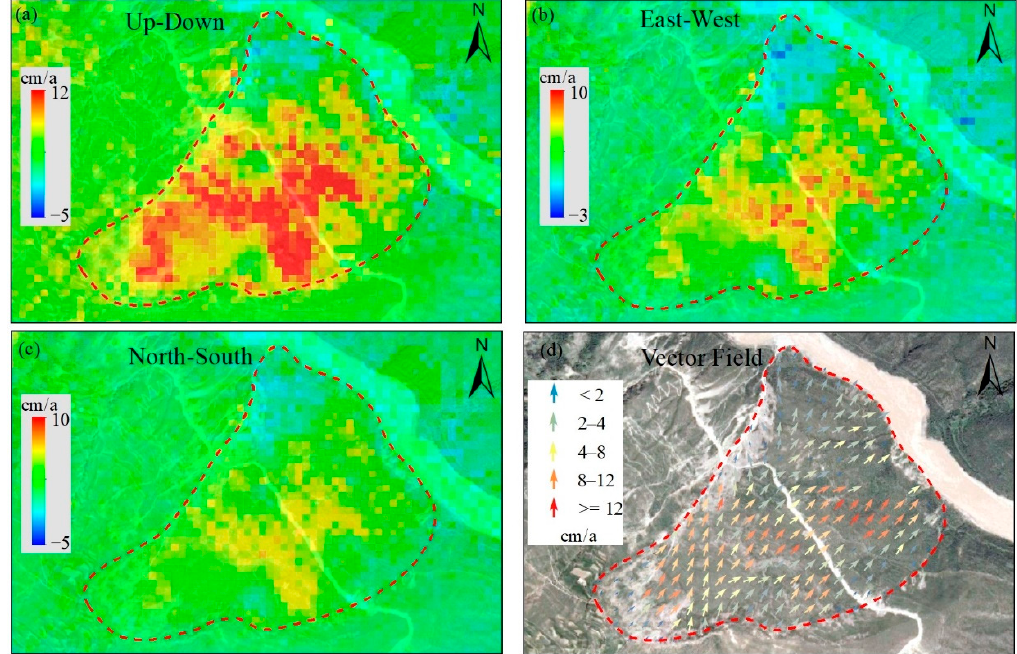
Figure 8. The 3D velocities field obtained from the three-dimensional decomposition method. ( a – c ) The velocities (cm/a) of the vertical, east-west and north-south directions; ( d ) horizontal velocity (cm/a). The red arrow represents a greater horizontal velocity.